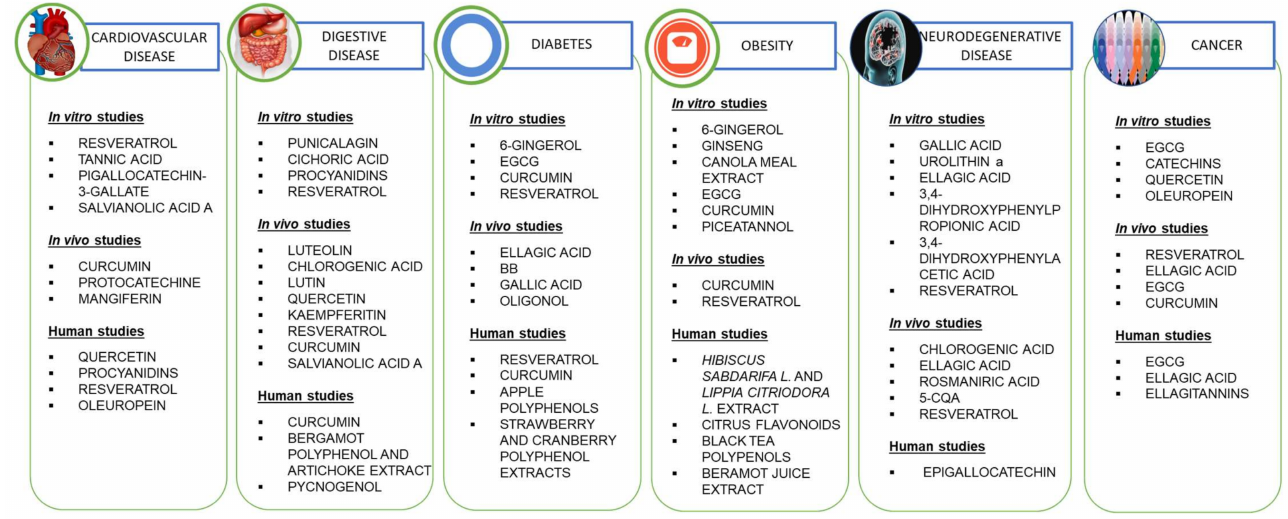
Figure 10. Summary of the effects of polyphenols in animal models, human studies, and in vitro. Supplementary Materials: The supplementary materials are available online at